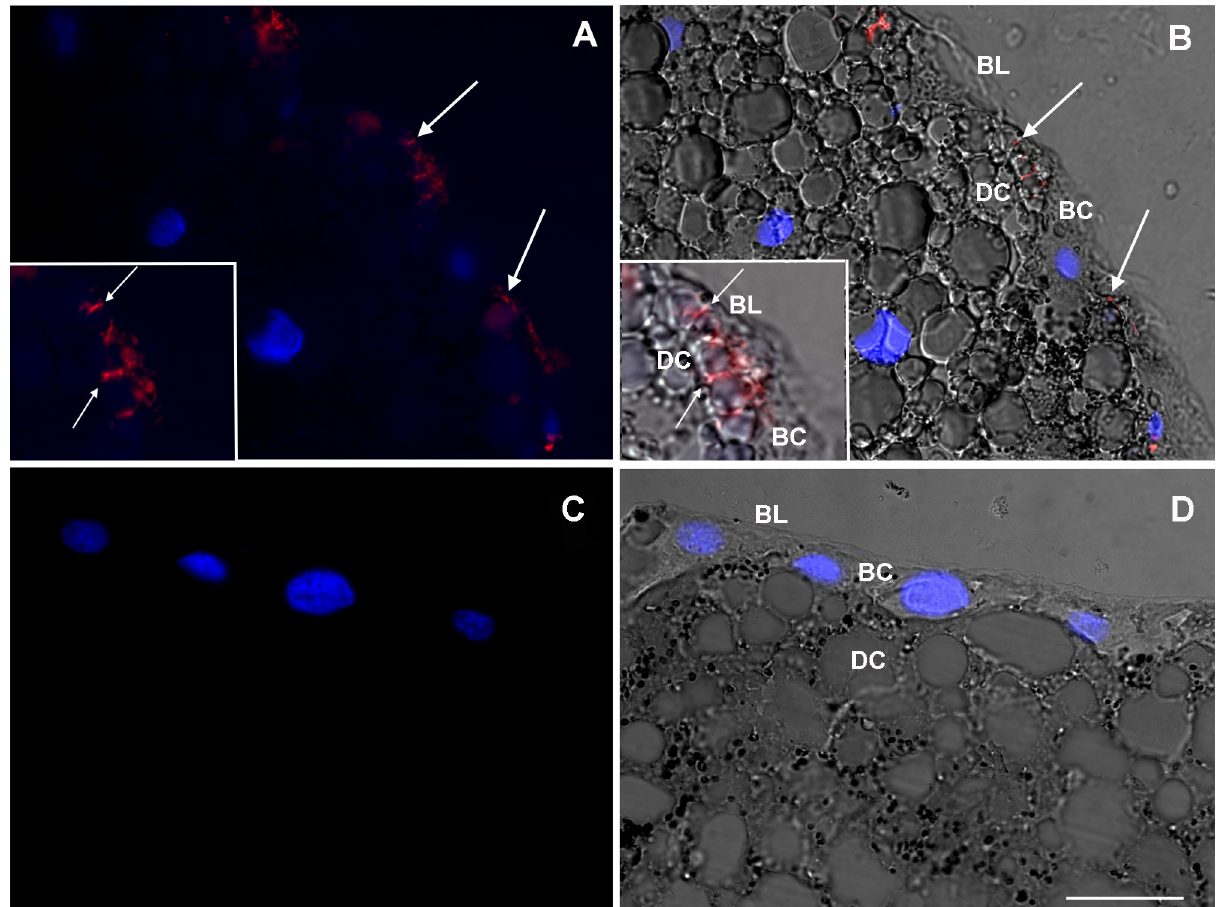
Fig 2. Immunolocalization of Mycobacterium LAM cell wall antigen in Amblyomma sculptum midgut 15 days after infection. Midguts from A . sculptum females after artificial feeding with uninfected (C, D) or M . leprae -infected (A, B) rabbit blood were fixed and sectioned. Panels A and C were generated through the merging of red channel image (anti-LAM + anti-mouse Alexa 594) with blue channel image (DAPI nuclear staining). Panels B and D were generated by merging with the differential interference contrast images. Almost all mycobacteria were observed in the basal region of the digestive cells (DC) (arrows). The images are representative of thirty fields, generated from three independent experiments: BL = basal lamina; BC = basophilic cell. Scale bar represents 15μm in main images and 7.5μm in insets.